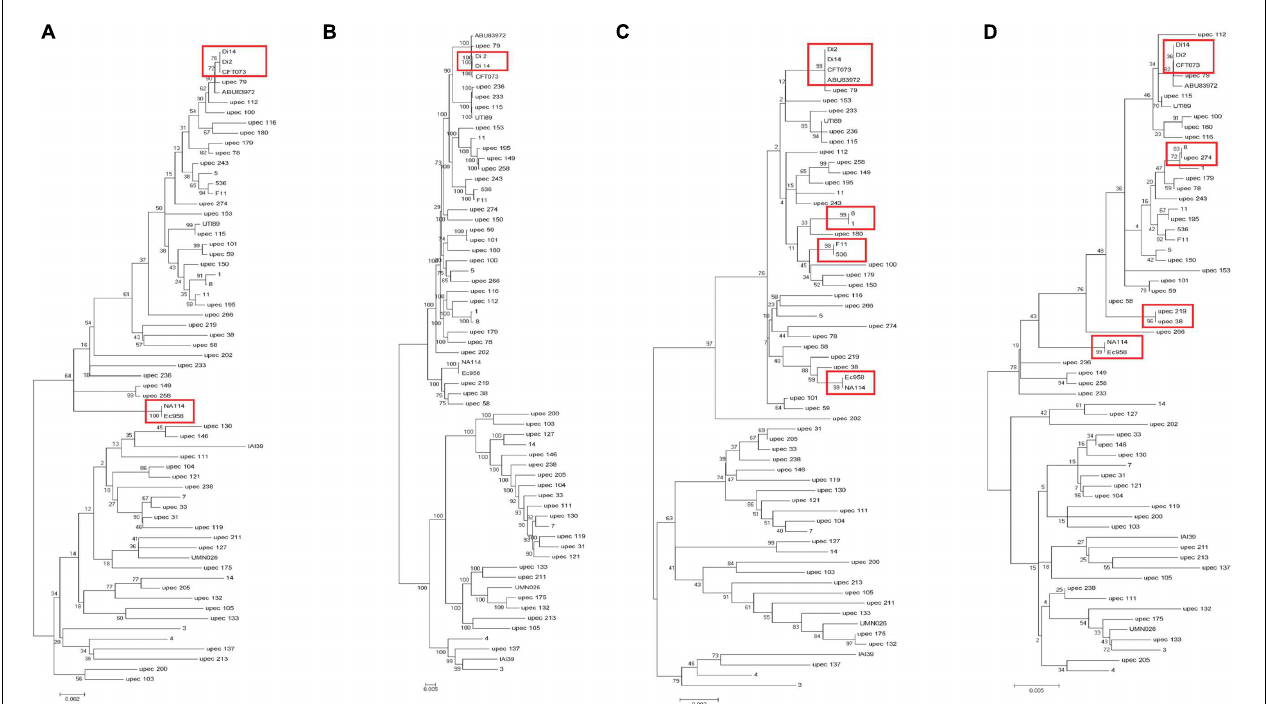
FIGURE 3 | Phylogenetic trees of 63 UPEC strains with available genome sequences based on (A) four genes ( yagV , fimF , fimH , and fumC ), (B) homologous genes, (C) MLST genes, and (D) the internal fragments of fimH and fumC . The scales at the bottoms of the trees indicate phylogenetic distance. Bootstrap values are displayed as percentages on nodes. Closely related strains are shown in red